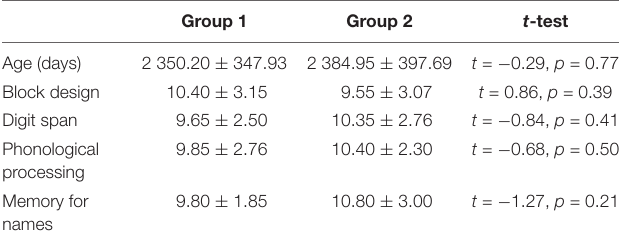
TABLE 1 | A comparison of the age and cognitive skill scores (mean ± SD) of participants for the intentional task with production and the incidental task (Group 1) and participants for the intentional task without production and statistical task (Group